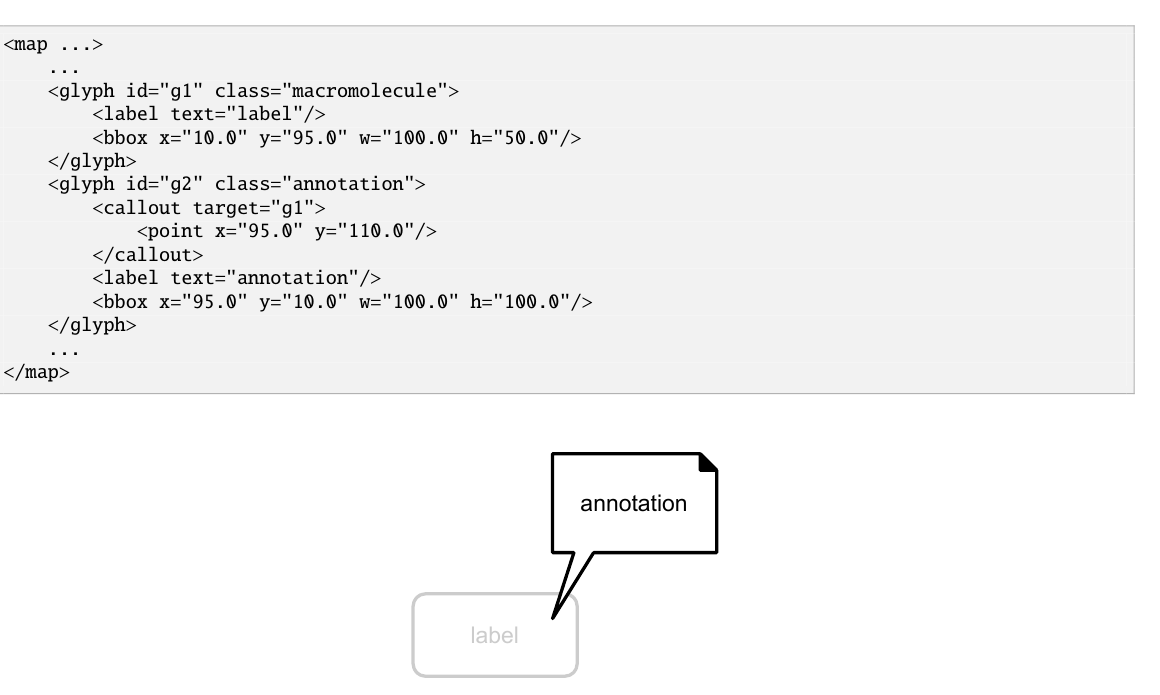
Figure 20: Visual representation of a Callout on a Glyph of class annotation pointing to a Glyph of the class macromolecule .